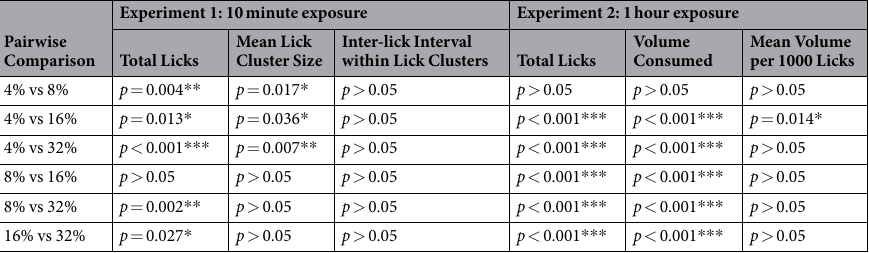
Table 2. Pairwise comparisons of the effect of sucrose concentration on licking behaviour in Experiments 1 and 2. Holm-Bonferroni-adjusted pairwise comparisons of the significant main effects of sucrose concentration that were identified in Table 1 to have occurred in the absence of a sucrose concentration x genotype interaction. Asterisks denote significance at various levels: * p < 0.05; ** p < 0.01; *** p <